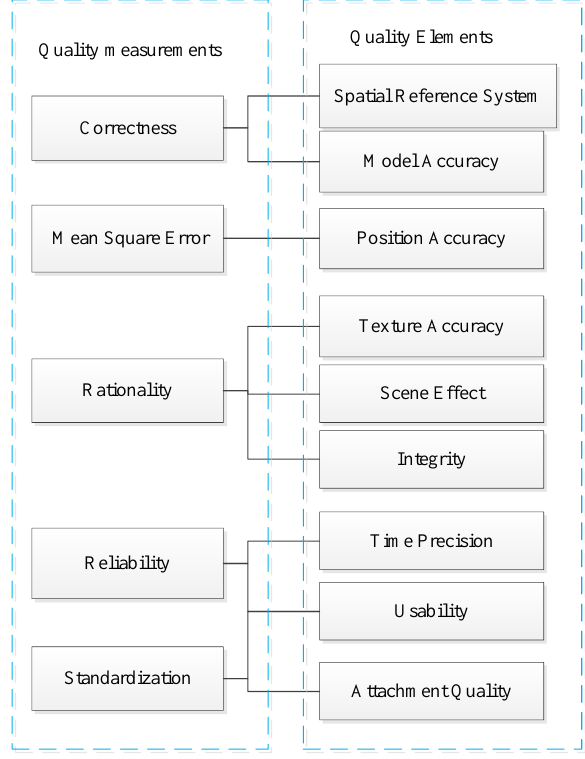
Figure 3. Real scene 3D model quality framework The spatial reference system is the location reference of the real- scale 3D model. The correctness of the spatial reference system determines the effectiveness of the real scene 3D